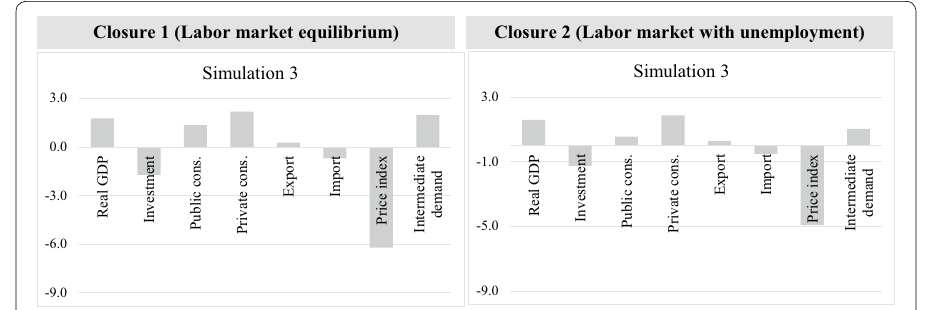
Fig. 6 Simulation results of demand and productivity shocks (% change from base data). Source : Author’s